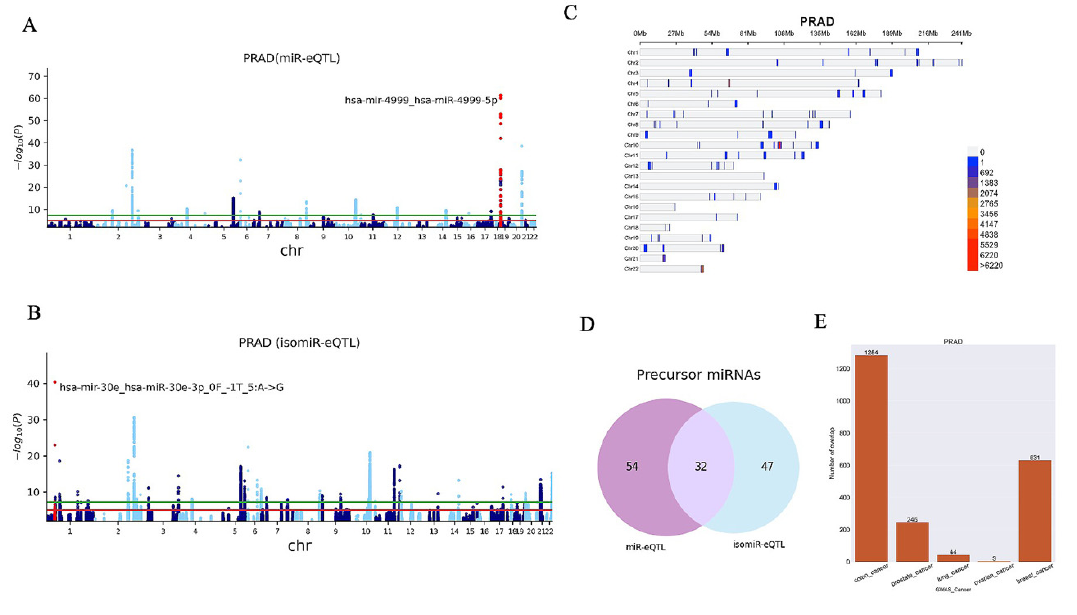
Figure 3. ( A ) The Manhattan plot of miR-eQTL. The most significant miRNA is labelled; it includes the name of the precursor and the miRNA. ( B ) The Manhattan plot of isomiR-eQTL. The most significant isomiR is labelled; it includes the name of the precursor and isomiR. ( C ) Density plot shows the position of all miR and isomiR-eQTL (FDR < 0.05) in the genome. ( D ) The Venn graph shows the numbers of miRNA precursors that were discovered in prostate cancer samples. ( E ) Bar charts show the number of